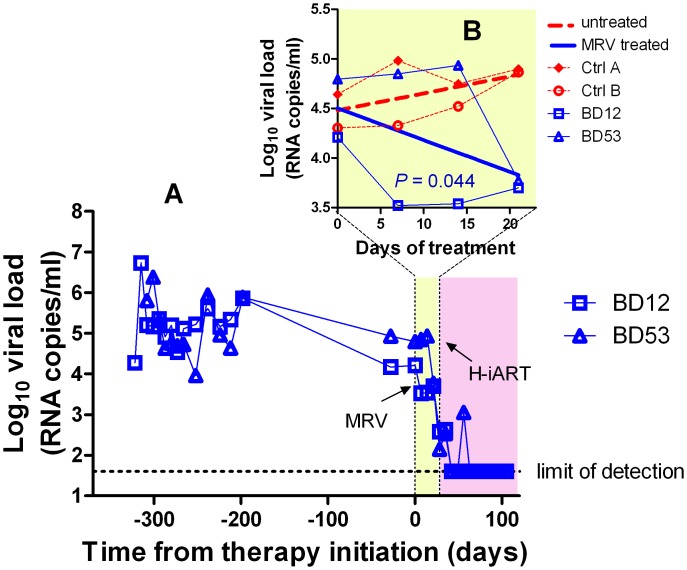
Ritonavir-boosted MRV (MRV/r) is able to decrease viremia in vivo.Panel A: Viral load measurements after infection and during treatment with MRV/r (light yellow) and H-iART (light purple). Panel B (detail): Viral loads during MRV/r monotherapy in comparison to viral loads of untreated controls.